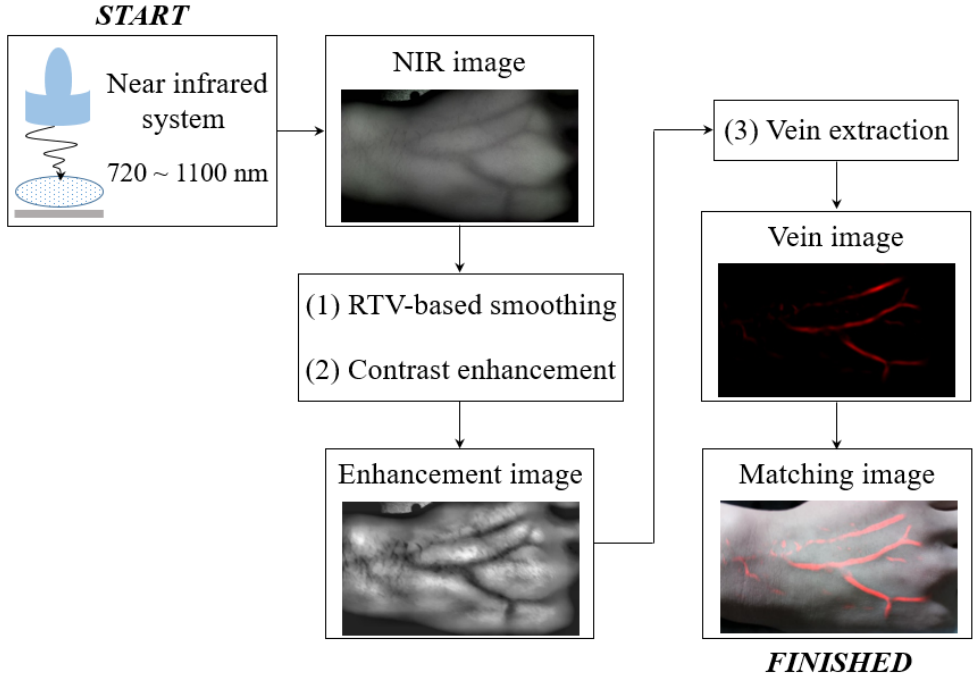
Figure 2. Flowchart describing the application of the proposed dorsal vein recognition framework to a near infrared (NIR) image.